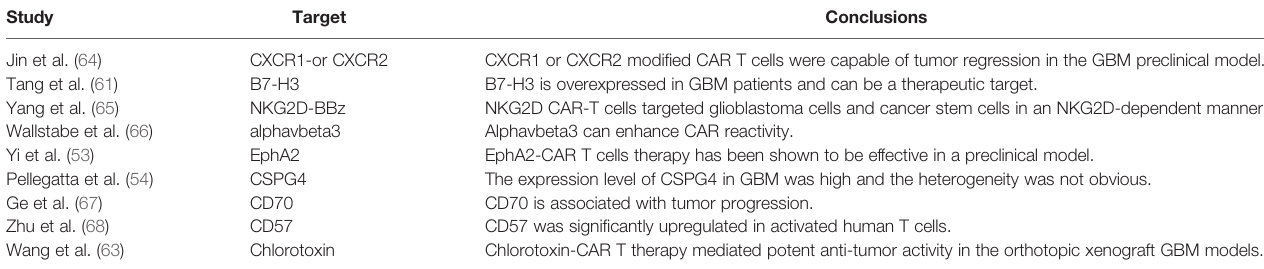
TABLE 2 | Published novel tumor antigen targets in CAR T therapy for GBM. Target